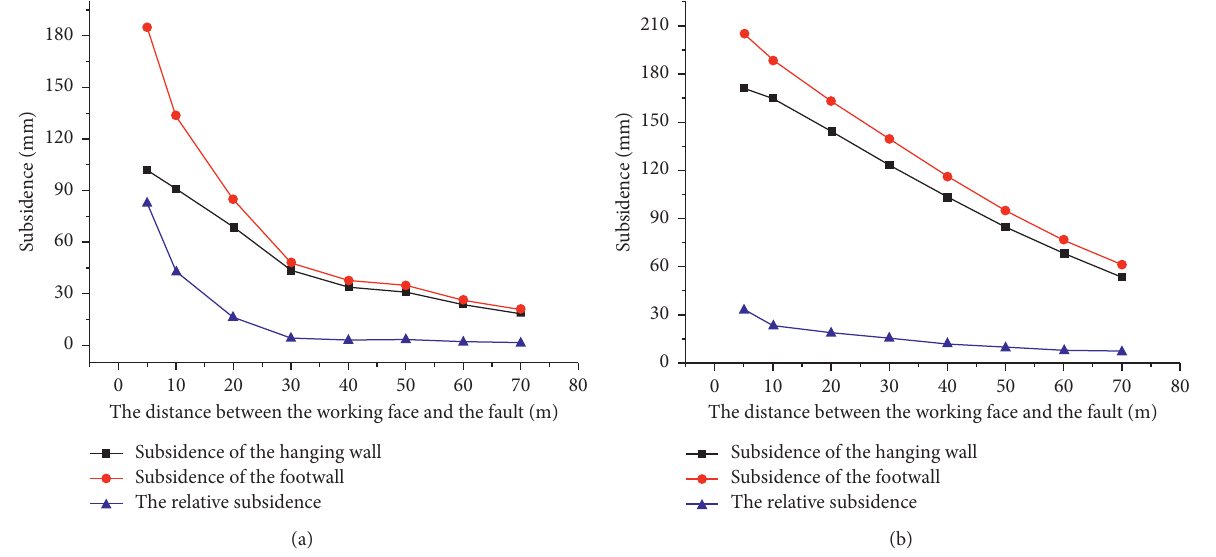
Figure 14: Two walls and the relative subsidence curves in footwall mining. (a) Point A ′ . (b) Point B ′